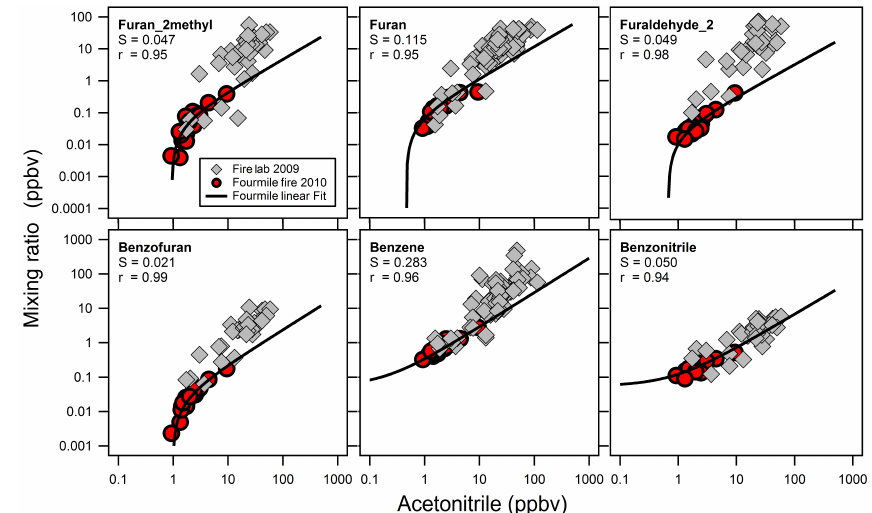
Figure 7. Correlation plots of VOCs versus acetonitrile for all 56 laboratory biomass burns (grey markers) and Fourmile Canyon Fire (red markers correspond to the BB plume identified in Fig. 6). The best-fit line for the Fourmile Canyon Fire samples is shown in black along with the slopes( S ) and fit coefficients ( r